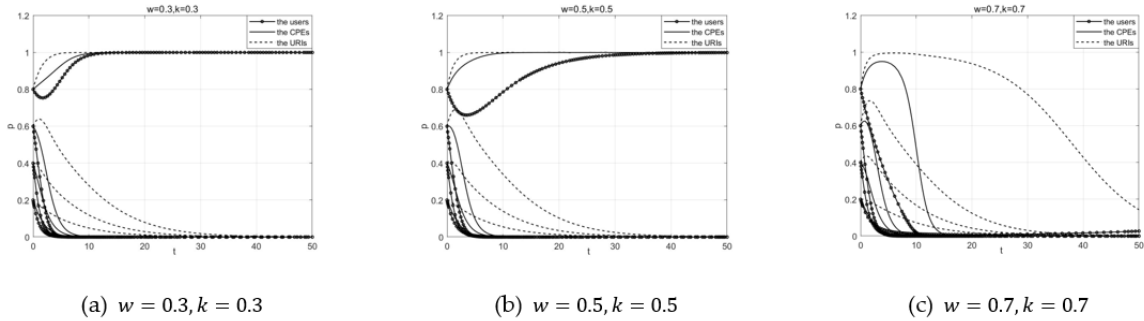
Figure 3. Impact of reward and penalty on the strategies of the Users, the CPEs and the URIs, and ( a – c ) show the evolution of the tripartite strategies under different values of w , k .